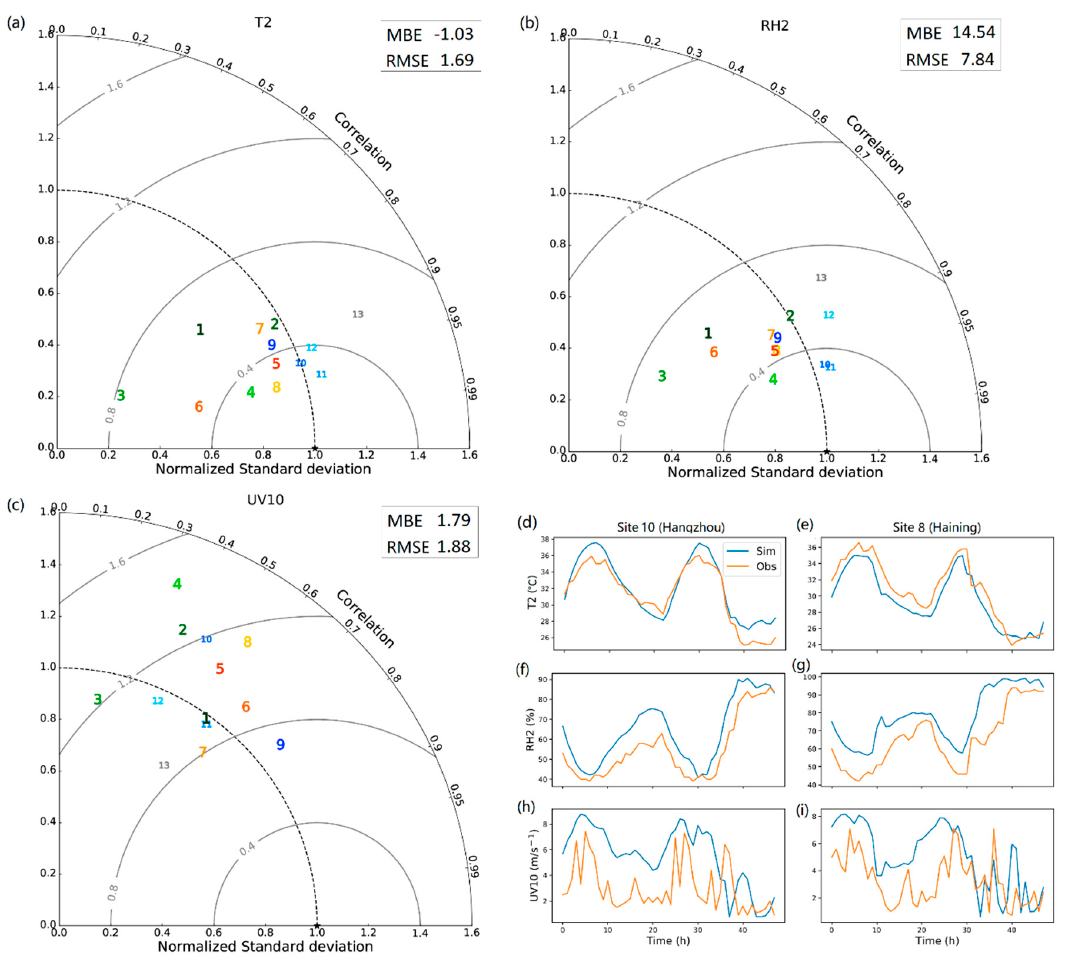
Figure 5. Weather research and forecasting (WRF)–urban canopy model (UCM) performance (00:00 4 July 2013 to 00:00 6 July 2013 UTC), evaluated using measurements at 13 CMA sites in Zhejiang Province (Figure 1b) for ( a ) 2 m air temperature ( ◦ C), ( b ) 2 m relative humidity (%), ( c ) 10 m wind speed (m s − 1 ), as well as time series of ( d , e ) 2 m air temperature ( ◦ C), ( f , g ) 2 m relative humidity (%), and ( h , i ) 10 m wind speed (m s − 1 ) for sites ( d , f , h ) #10 (Hangzhou) and ( e , g , i ) #8 (Haining). ( a–c ) Taylor [52] plots are for hourly data with correlation coe ffi cients (polar axis), with normalized standard deviation (horizontal axis) and normalized root mean square error (RMSE) (internal circular axes). The overall, cross-site, mean bias error (MBE) and RMSE are also indicated.